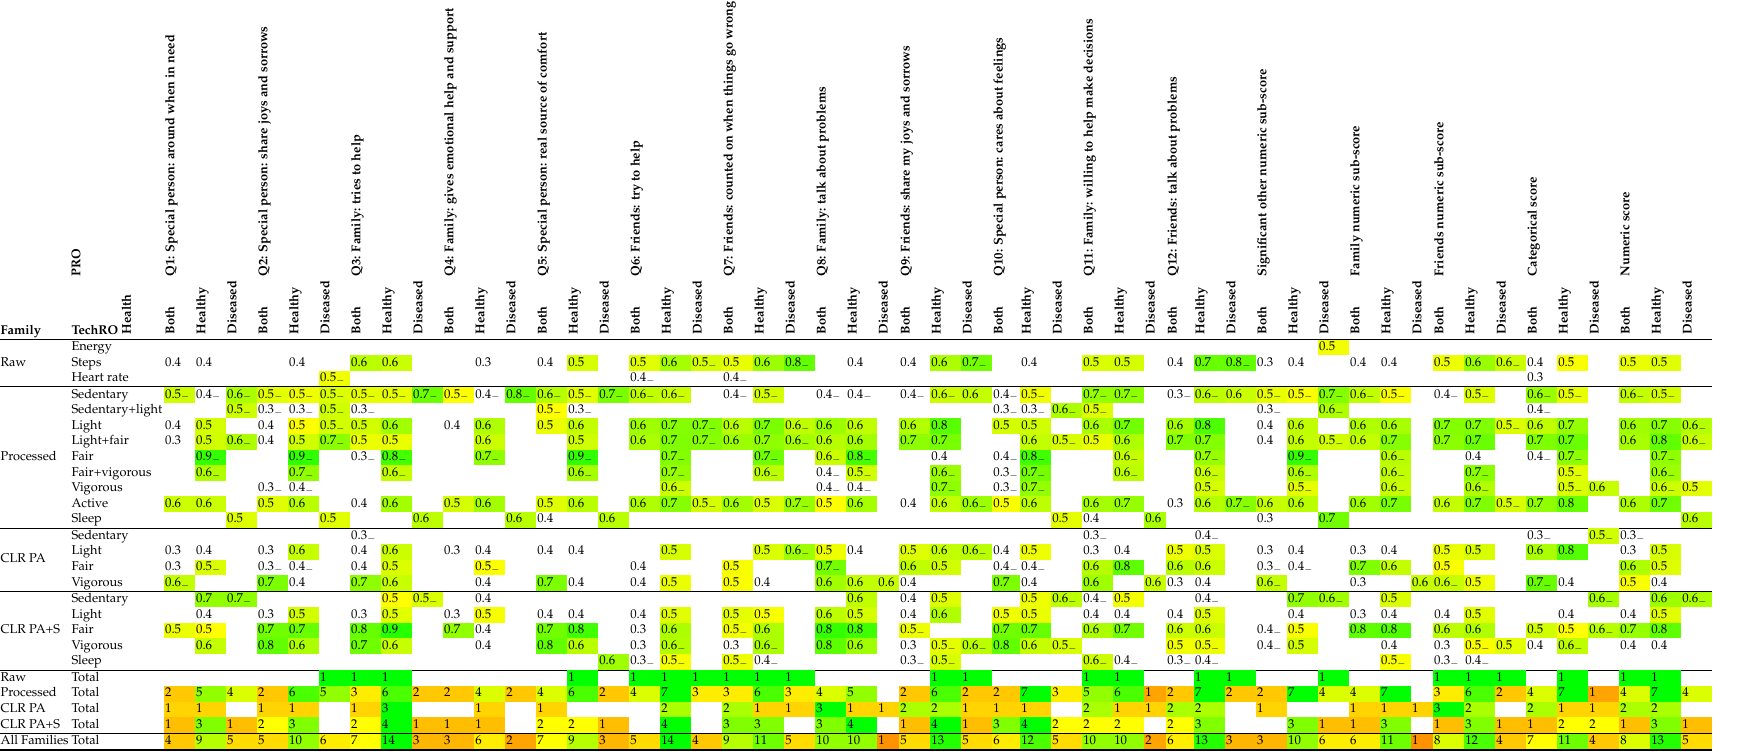
Color coding: from orange (weaker correlation/fewer total correlations) to yellow to green (stronger correlation/more total correlations). Only significant correlations are shown. Only coefficients of 0.5 or above are